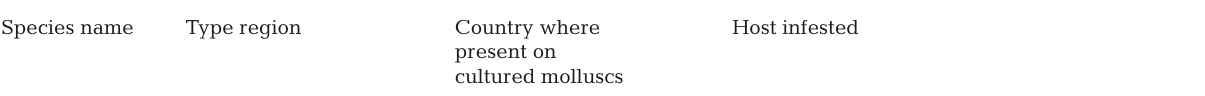
Table 1. Global distribution of shell-infesting and pest species that are associated with cultured or commercially harvested mol- luscs. Excludes species identified just to genus level. Pest status in native and invasive range given as pest (p), common (c), or rare (r). Larval developmental mode: adelphophagy (ad), lecithotrophy (le), planktotrophy (pl), poecilogony (po). Culture